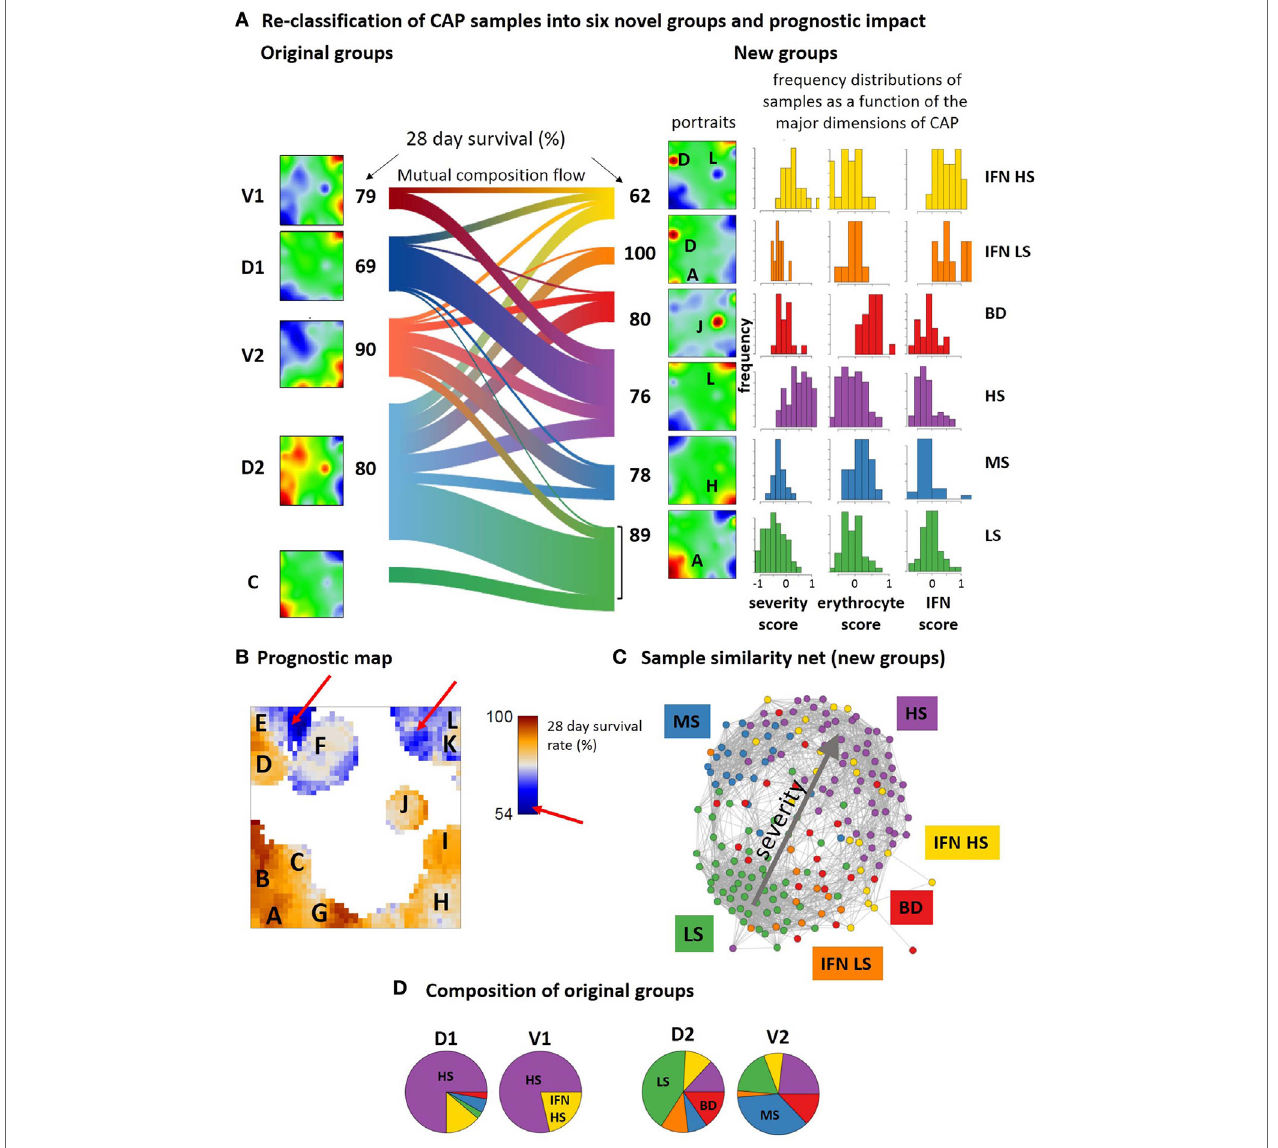
FigUre 9 | Re-classification of community-acquired pneumonia samples into six novel groups and their prognostic impact. (a) The sankey diagram (R-program “riverplot”) illustrates the composition flow between the original and novel classes [low, medium and high severity, LS, MS, HS, respectively; blood disturbances (BDs); IFN high and low or middle severity, IFN LS and IFN HS, respectively], while the class-averaged mean portraits visualize the respective expression landscapes. The new subtypes differ with regard to severity levels (low, medium, high, spots A, H, and L) and the expression of spots J and D being assigned to BDs and interferon response, respectively (see also Table S4 in Supplementary Material). (B) The prognostic map links the expression level with the 28-day survival rate where the latter is calculated as the percentage of patients expressing the respective metagene and surviving 28-days after admission in intensive care unit. (c) Re-coloring of the correlation net according to new classification illustrates the asymmetrical distribution of the novel groups with respect to the discovery and verification cohorts (compare with the similarity net in Figure 1a ). (D) The pie charts show the composition of the original groups with respect to the new ones. Note that about 65% of group 1 cases are collected in the novel HS group, while the remaining cases are mainly assigned to IFN HS. In contrast, about 50% of group 2 cases consist of LS and MS cases, while the remaining half of the cases distribute over the remaining